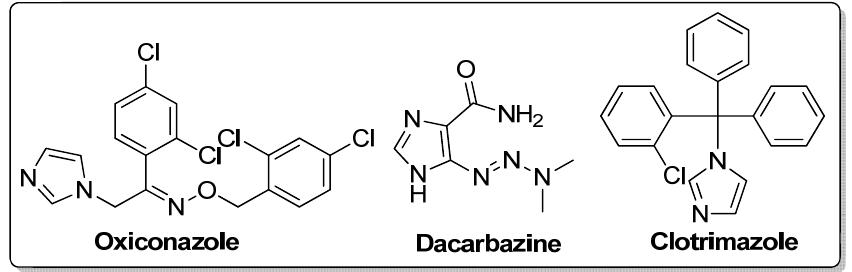
Figure 16. Imidazole clinical drugs.